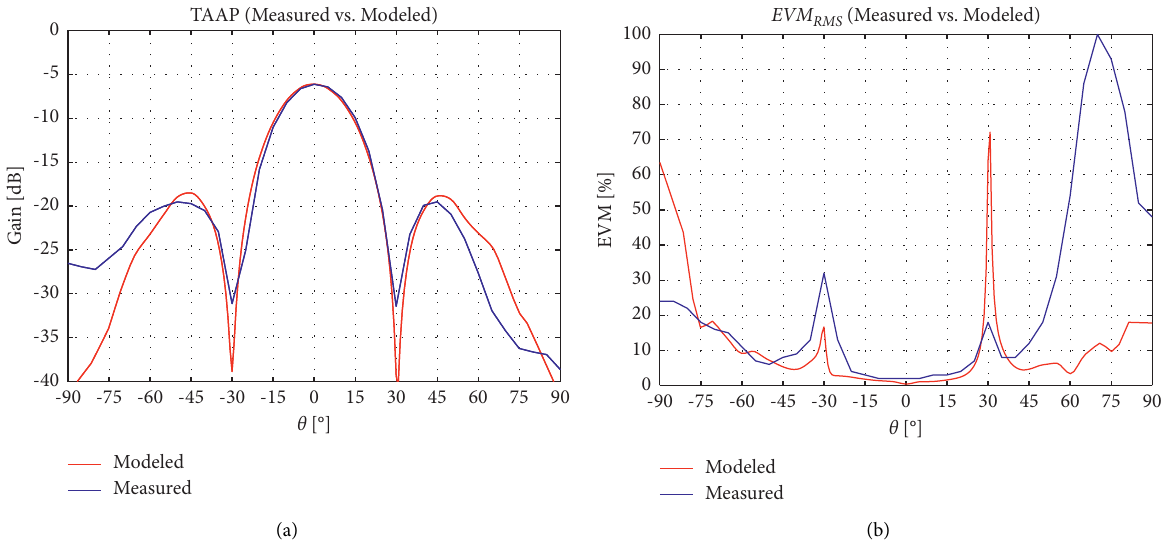
Figure 13: Demonstrator outspacing performance. The nonsymmetric configuration is measured in the anechoic chamber over the φ � 0 ° plane. As a reference, the modeled result including embedded element pattern is shown. K � L � 4, d x � d y � ( λ signal is QAM16. (a) Time average array pattern. (b) EVM.